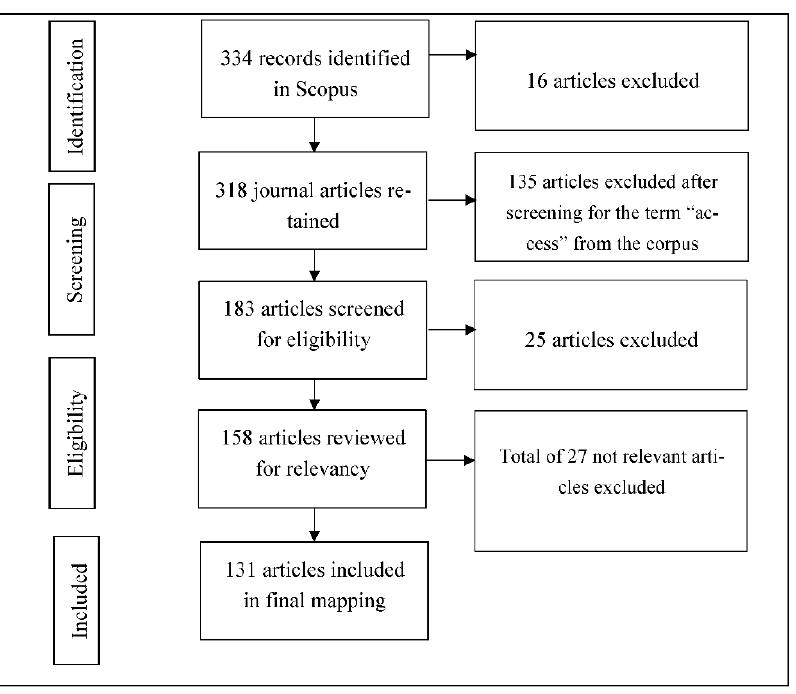
Figure 2. Search process and